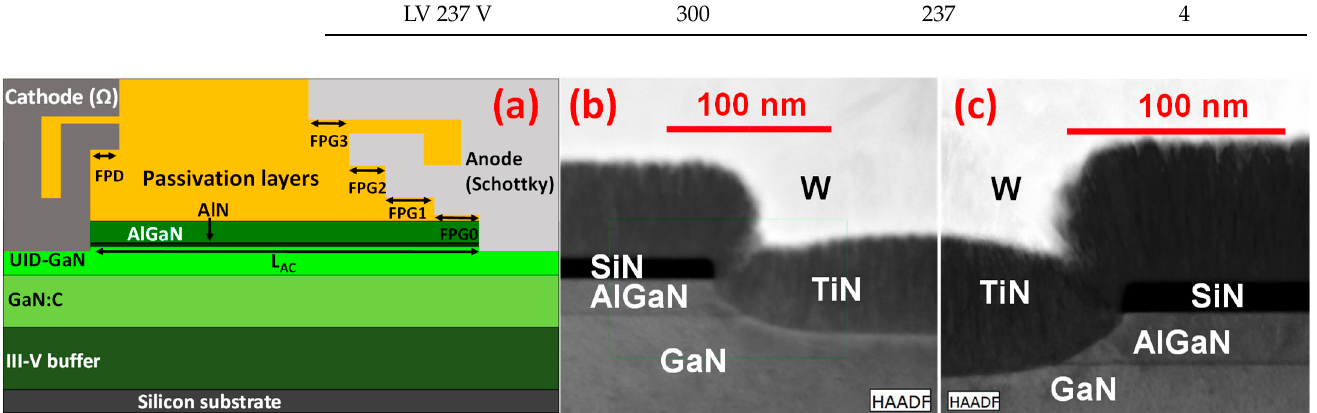
Figure 1. ( a ) Detailed cross-section of the structure; ( b ) STEM observation of the LV 90 V Schottky interface; ( c ) STEM observation of the LV 237 V Schottky interface.